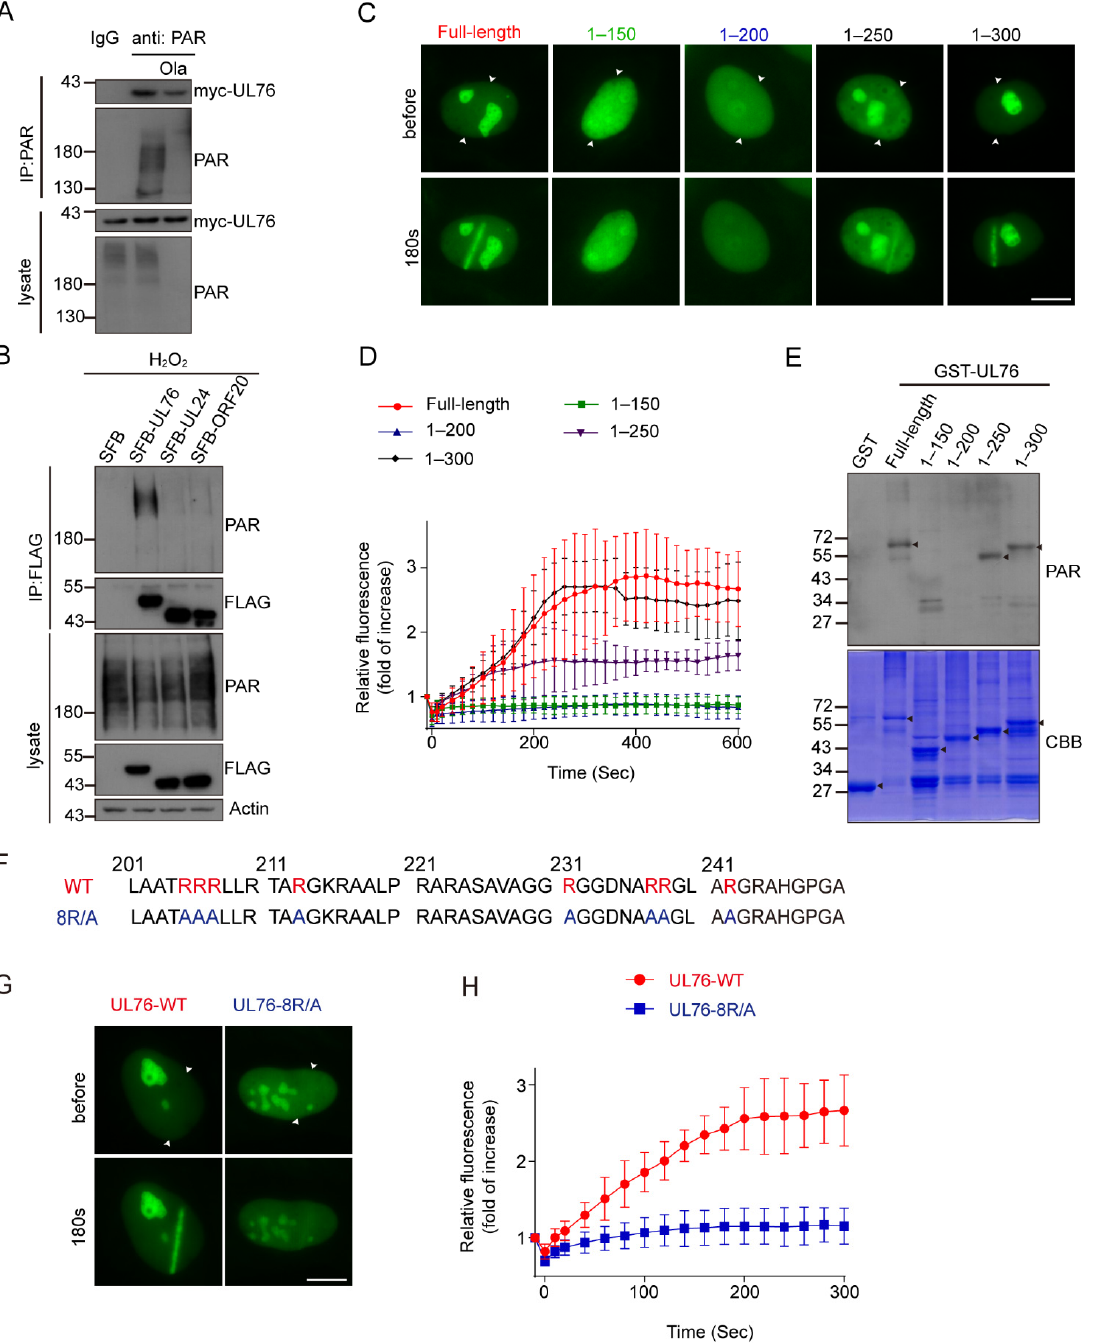
Figure 7. UL76 directly bound to PAR via RG/RGG motif. ( A ) Myc-UL76 was transfected to 293T cells. The cells were harvested, and the whole cell extracts were subjected to immunoprecipitation with PAR antibody or control IgG. The presence of PAR and UL76 in the immune complexes was determined by Western blot with indicated antibodies. Olaparib treatment inhibited the production of PAR and decreased the amount of UL76 immunoprecipitated by PAR antibody. ( B ) SFB-tagged UL76 or its analogs were transfected to HEK293T cells for 48 h. Cell lysates were subjected to immunoprecipitation assay using Flag antibody. Only UL76 could pull down endogenous PAR chains. ( C ) Mapping of the decisive region in UL76 for its ability to accumulate at DNA damage sites. Different truncates of UL76 were transfected to HeLa cells. GFP-positive cells were irradiated by laser micro-irradiation. Paired arrowheads indicated the orientation of the laser track. Scale bar, 10 µ m. ( D ) Kinetics of the